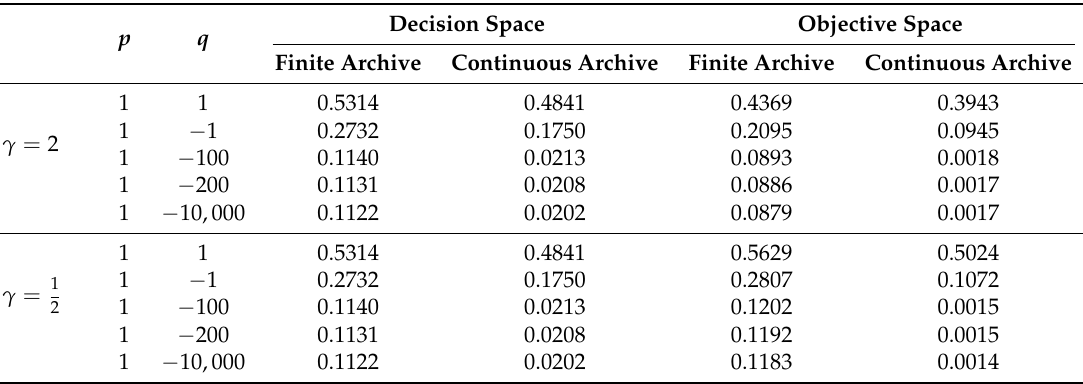
Table 2. ∆ p , q values for the Pareto set/front approximations for MOP (12).